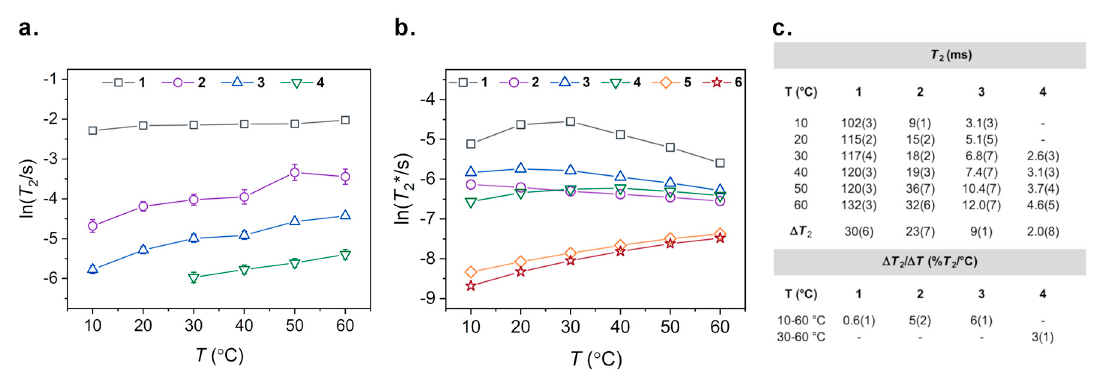
Figure 3. ( a ) Variable-temperature T 2 plots of 1 – 4 on logarithmic scale showing relative changes in T 2 spin–spin relaxation times. Error bars for K 3 [Co(CN) 6 ] ( 1 ) are within the width of the data points. Traces in both plots are mean to guide the eye. ( b ) Variable-temperature T 2 * trends from linewidth analyses of 1 – 6 from 1D 59 Co NMR spectra. ( c ) Temperature-specific T 2 spin–spin relaxation times with error for 1 – 4 with absolute values of ∆ T 2 and relative values of ∆ T 2 / ∆ T temperature sensitivities.